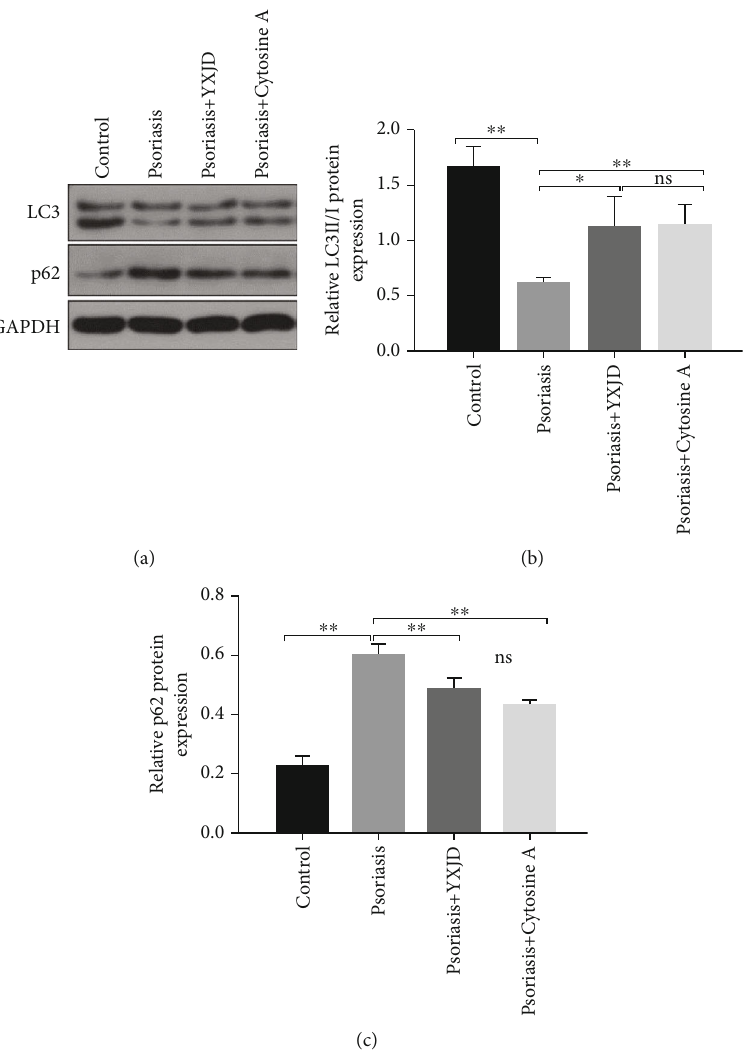
Figure 6: Protein levels of LC3II/I and p62, as detected by Western blot. LC3II/I and p62 expression were evaluated by Western blotting (a –